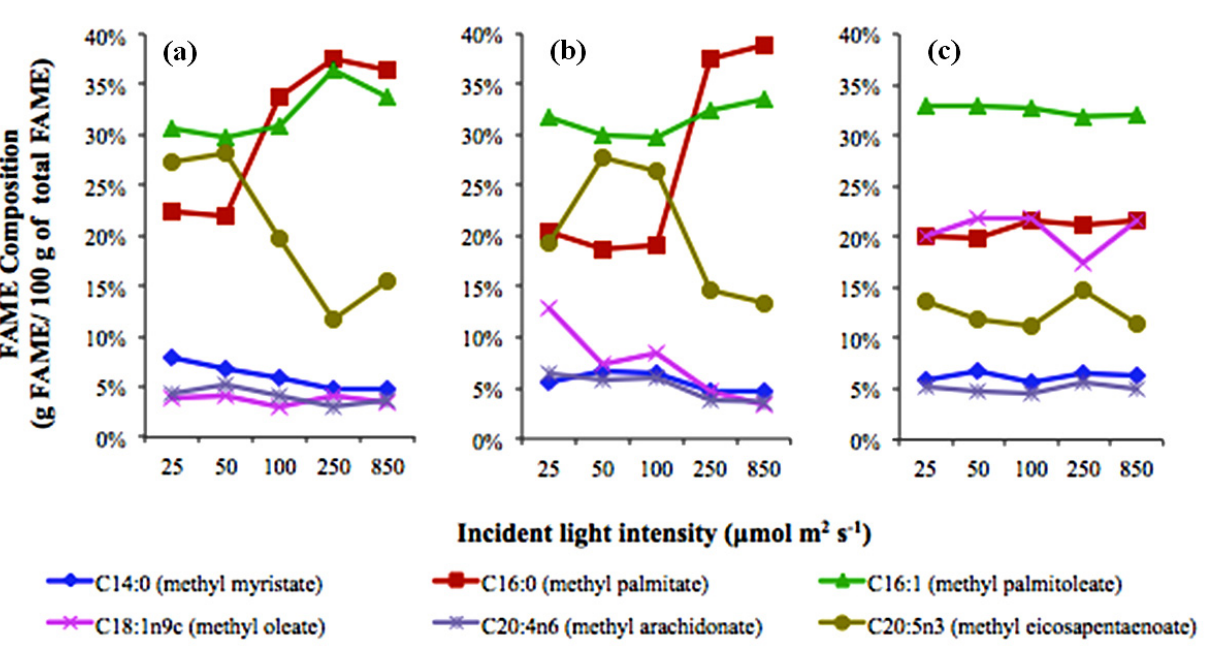
Figure 3. Fatty acid composition as a function of incident light intensity in Roux bottle photobioreactors in ( a ) exponential ( b ) early linear ( c ) late linear growth